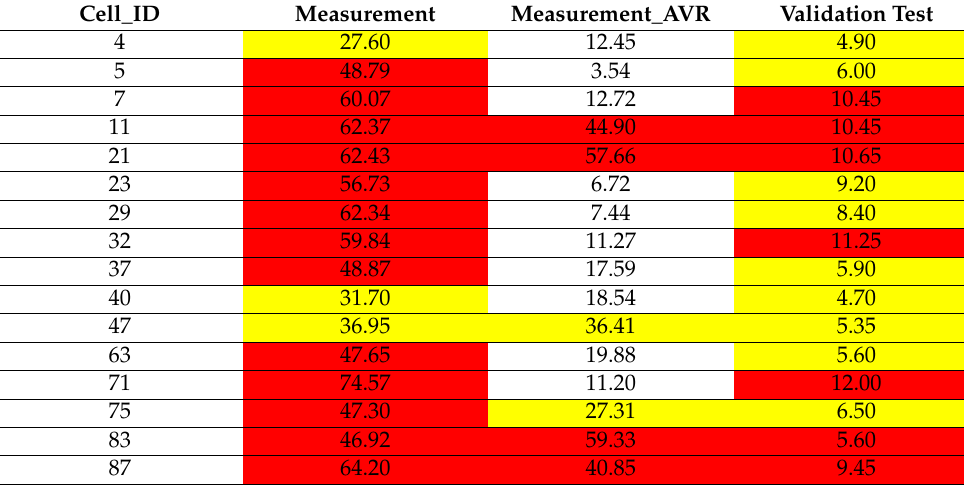
Table 2. Critical cells by ID in the different tests (based on Figure